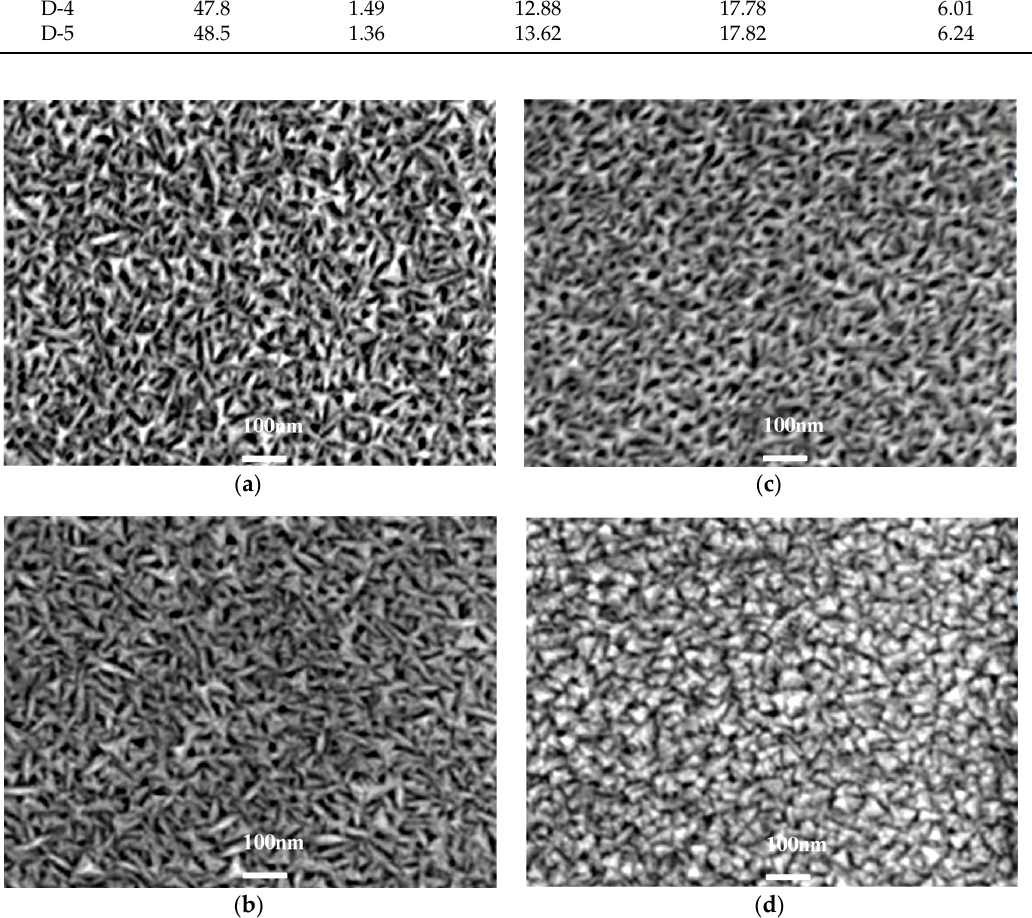
Figure 3. SEM images of Mo films deposited at different substrate temperature and annealing temperatures: ( a ) 200 °C substrate heating and 300 °C annealing; ( b ) 400 °C substrate heating and 300 °C annealing; ( c ) 200 °C substrate heating and 400 °C annealing; and ( d ) 400 °C substrate heating and 400 °C annealing.